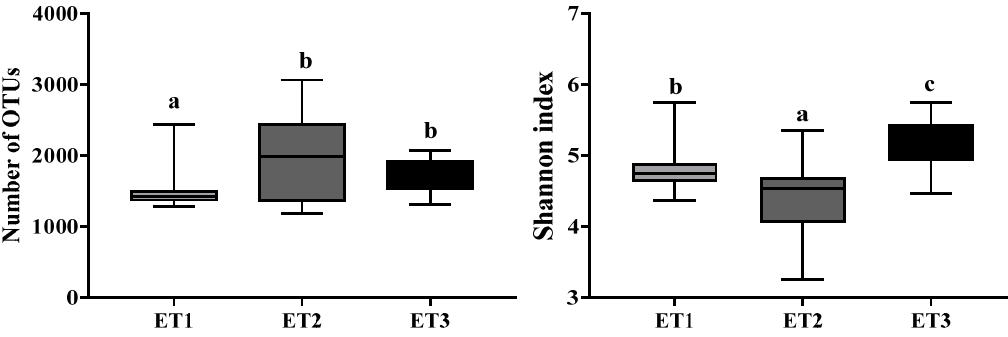
Figure 2. The α -diversity of the three enterotypes. The boxplot shown are means, ranges, and the first and third quartiles. Different letters indicate a significant difference ( p < 0.05) with the 95% confidence interval. Abbreviation: ET, enterotype.